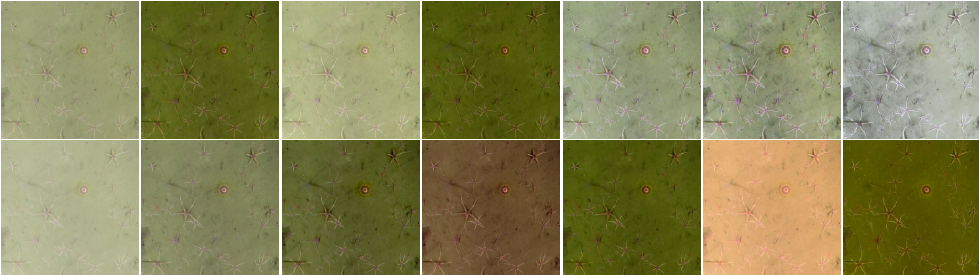
Figure 3. Example result of underwater image enhancement (left to right, starting from the top row): original raw image, DCP, MIP, RoWS, Paralenz, CLAHE, Fusion, GC, ICM, RGHS, UCM, UDCP, ULAP,